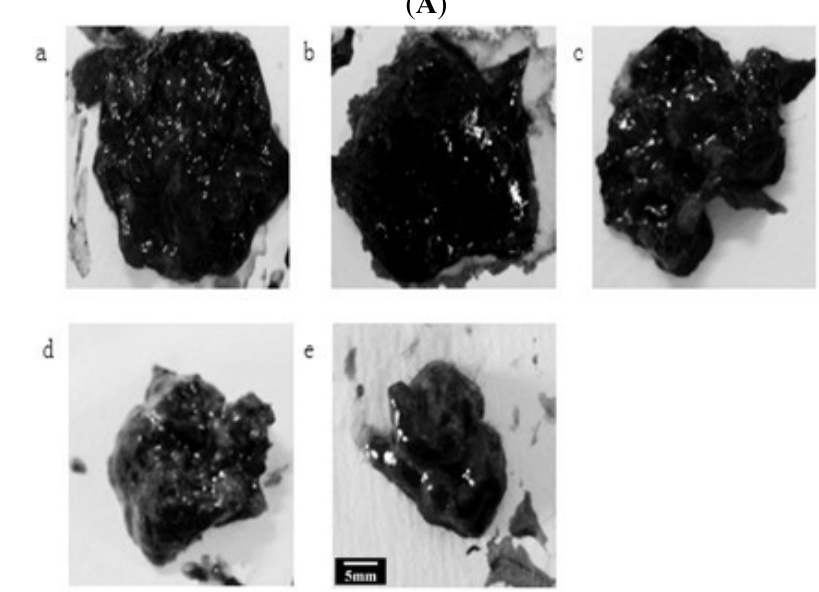
Figure 5. Celastrol-loaded liposomes attenuated tumor growth in vivo . ( A ) are presentative figures of tumors excised from C57BL/6 mice. a: blank control group with 0.9% NaCl; b: 2 mg/kg celastrol in 0.2% CMC-Na; c: the vehicle, namely, 2 mg/kg drug-free liposomes; d: 2 mg/kg celastrol-loaded liposomes (CLL), a–d were intragastrically administered every day; e: 20 mg/kg cyclophosphamide (CTX) by intraperitoneal injection. Tumor weight were summarized as shown in ( B ). Tumor inhibition rates accounted for tumor weight were shown in ( C ). Bar = 5 mm. * p < 0.05, ** p < 0.01 versus 0.9% NaCl blank control